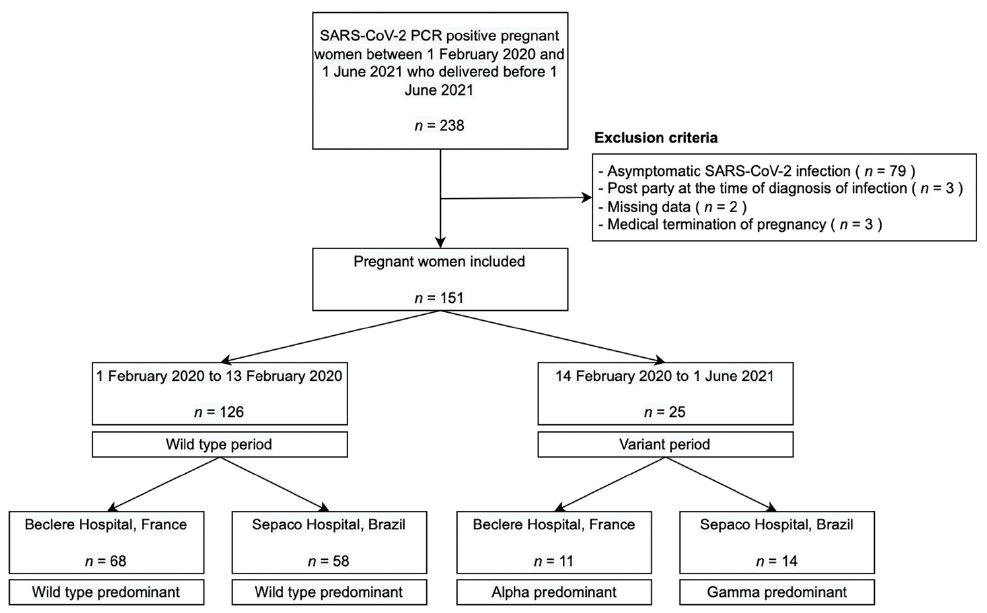
Figure 1. Flowchart.